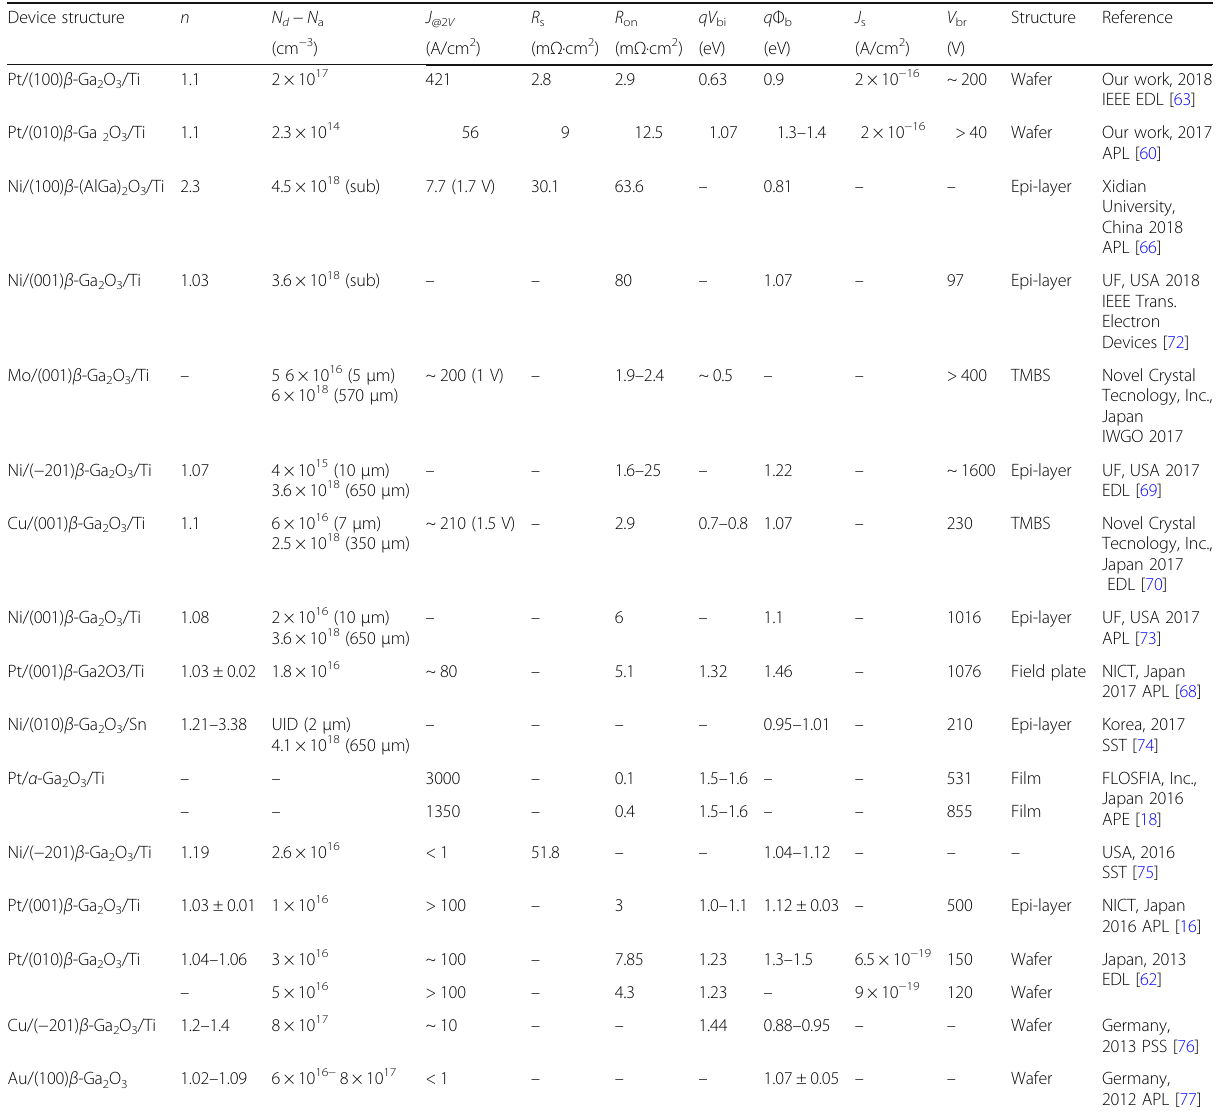
Table 2 Basic performance parameters of reported Ga 2 O 3 Schottky barrier diode since 2012 Device